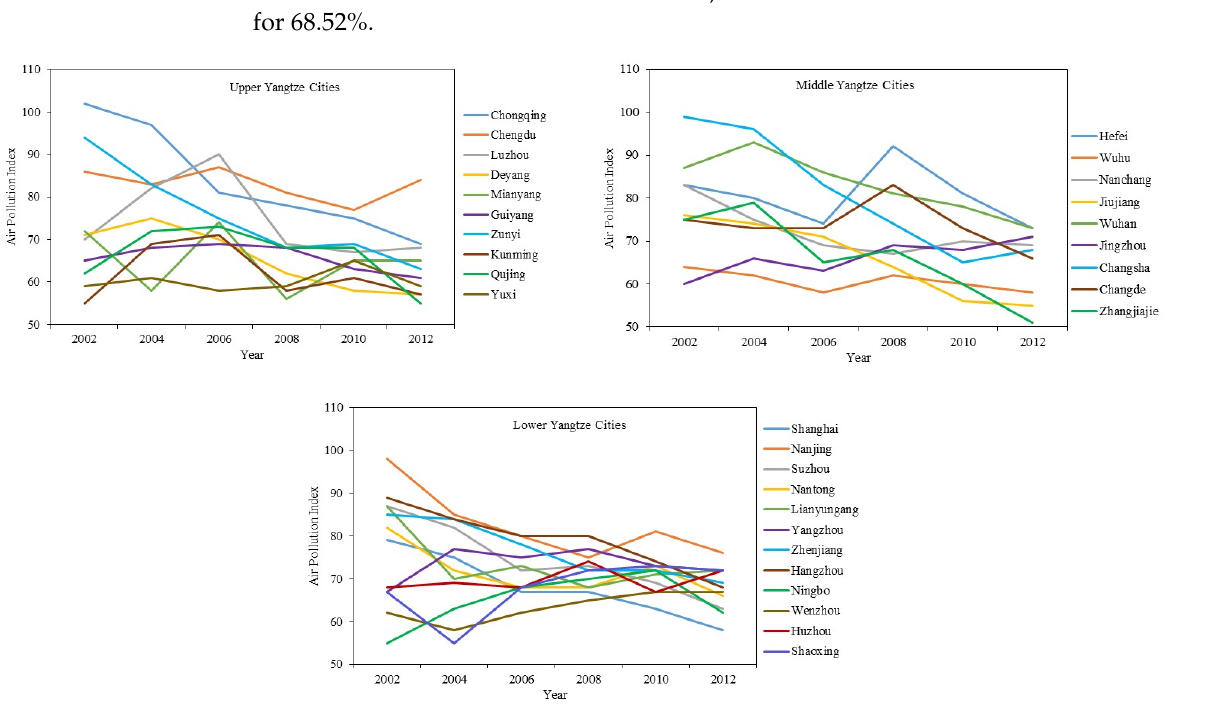
Figure 2. Annual change of air pollution in the YREB from 2002 to 2012.